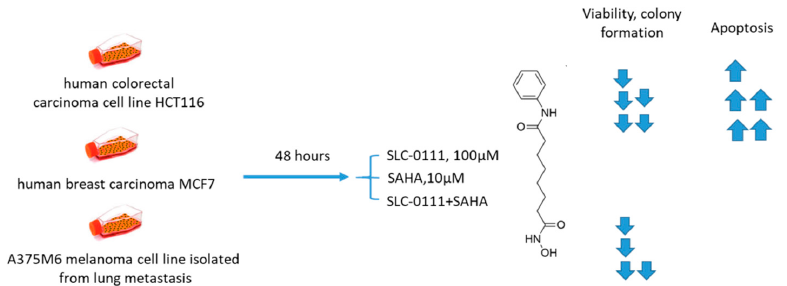
Figure 18. Graphical outline of the study on SLC-0111+SAHA combination reported by Ruzzolini et al. [90].